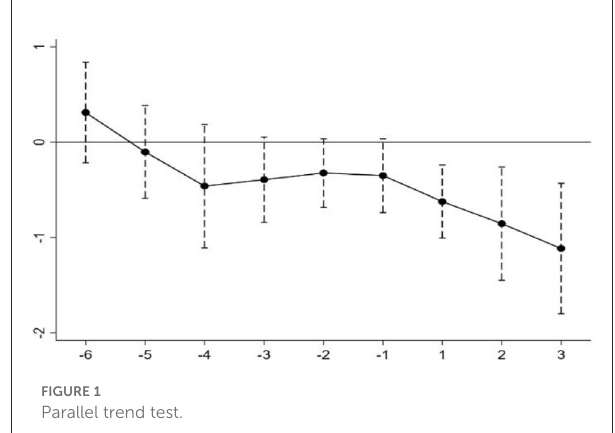
FIGURE1 Parallel trend